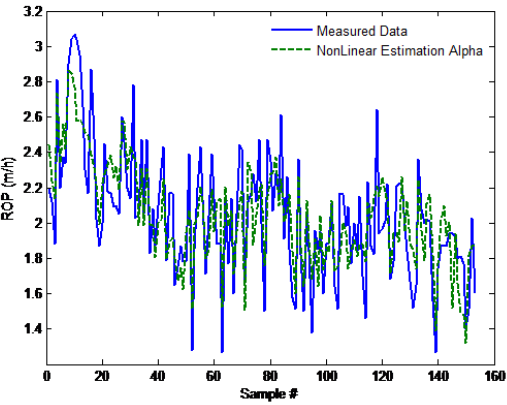
Figure 5: Nonlinear regression model with exponential Alpha.